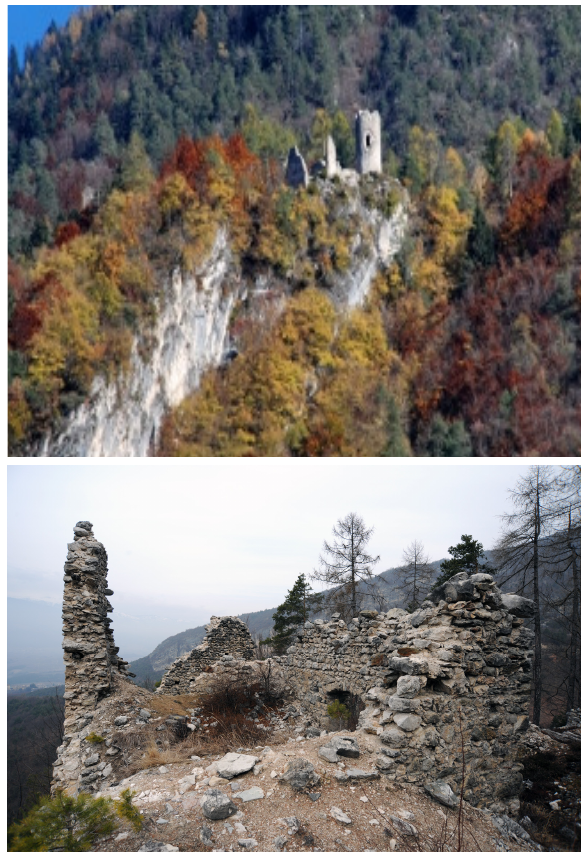
Figure 14: The castle location and a part its ruined structures. Due to occlusions, irregular surfaces and the requirements to deliver contours even for the surrounding terrain, the surveying is performed with a TOF laser scanner (Leica Scan Station 2), a much faster and reliable 3D recording instrument in the aforementioned conditions. Digital images are acquired separately in order to produce orthophotos of the vertical structures for architectural and archaeological purposes. The unfavourable location with a difficult accessibility required the use of donkeys to transport all the surveying instruments. The range data consist of approximately 8 million points, acquired from 15 different stations with an average sampling step on the structures of 2 cm. After editing cleaning, alignment and geo- referencing, the final point cloud is converted into a polygonal mesh consisting of more than 9.5 million triangles, which are classified in different groups (both natural and man-made) that compose the whole heritage structure. From the 3D model and according to a global reference system, contours with an equidistance of 10 cm are produced for each classified